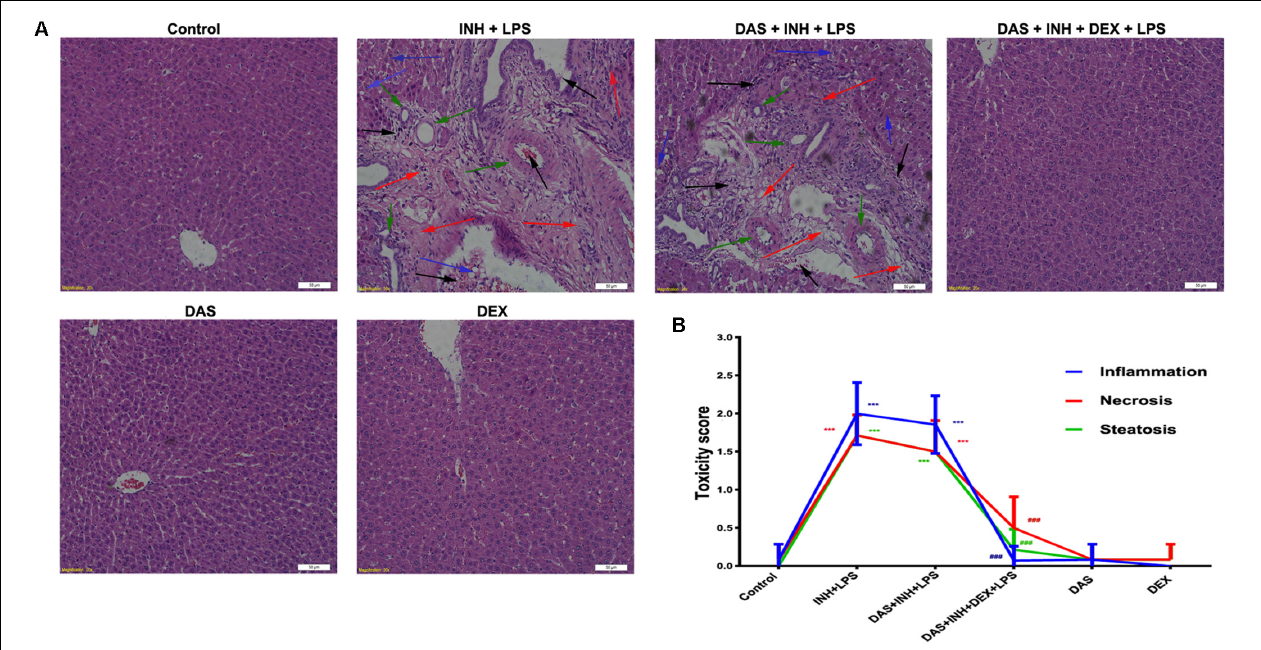
FIGURE 2 | Liver histopathological analysis after 2-week INH/LPS co-treatment combined with DAS and DEX. (A) Liver slices were collected and subjected to staining with hematoxylin and eosin. The control group shows normal hepatocyte architecture; meanwhile, INH/LPS co-treated animals’ liver showed sever toxicity symptoms. Inflammatory cells and inflammatory infiltration (black arrow), bile duct hyperplasia (green arrows), micro- and macrovesicular steatosis (blue arrow), massive necrosis, and hepatocellular structure loss (red arrow). Furthermore, addition of DAS revealed the same toxicity symptoms. On the other hand, both DAS and DEX pre-treatment caused complete liver protection as appeared by the absence of these liver injury indicators. (B) INH/LPS hepatotoxicity score in the absence or presence of DAS and DEX. Data are given as means ± SD, n = 7 for each bar, ∗∗∗ P < 0.001 versus control, ### P < 0.001 versus INH/LPS combination.